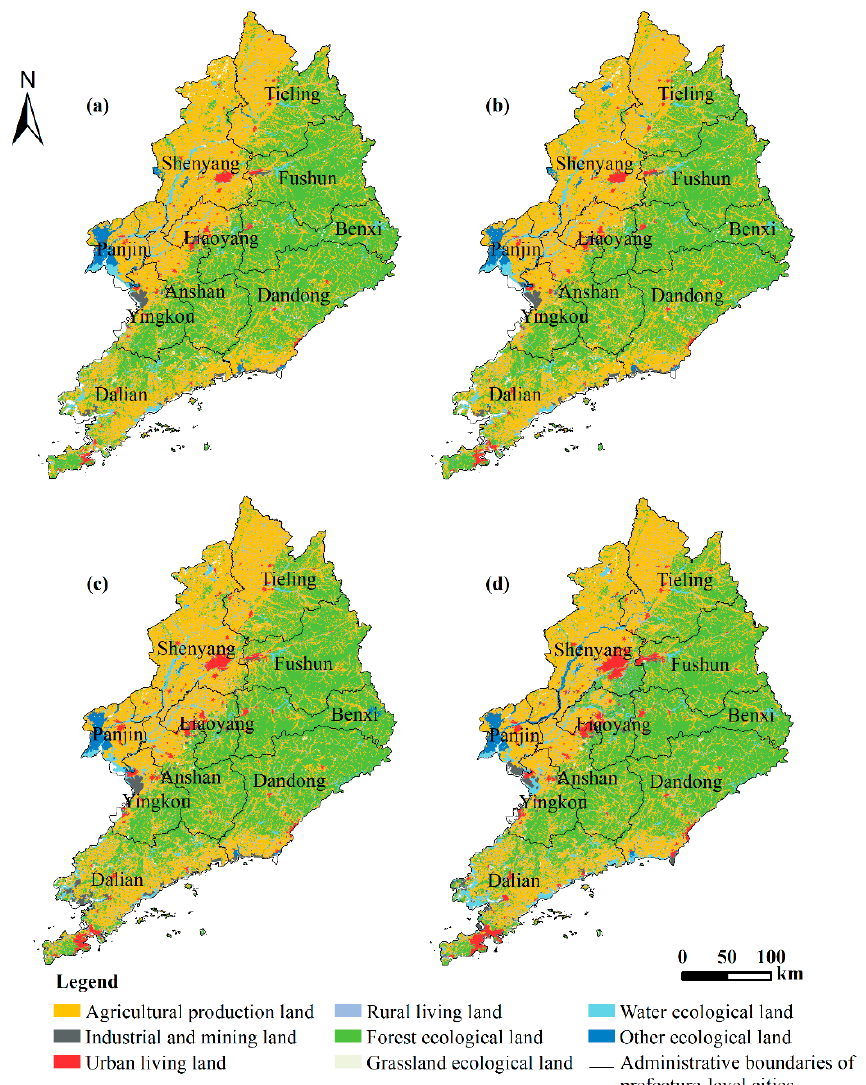
Figure 2. The production–living–ecological land use of the central and southern Liaoning urban agglomeration 1990–2018. ( a ) 1990; ( b ) 2000; ( c ) 2010; ( d ) 2018. Table 4. Area and changes of land-use types in the central and southern Liaoning urban agglomer- ation 1990–2018 (km 2 ).